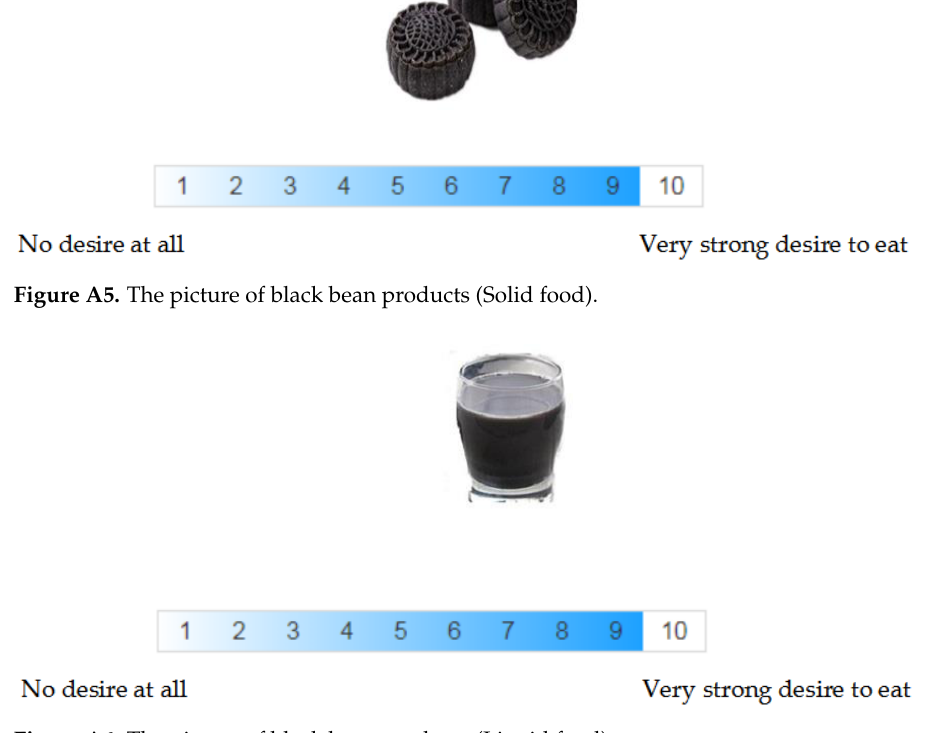
Figure A6. The picture of black bean products (Liquid food).